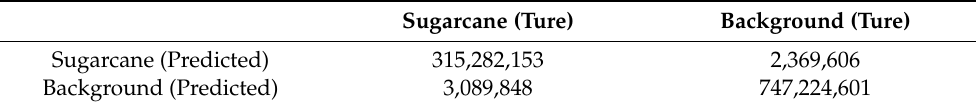
Figure 9. DeepLabV3+ network training loss.